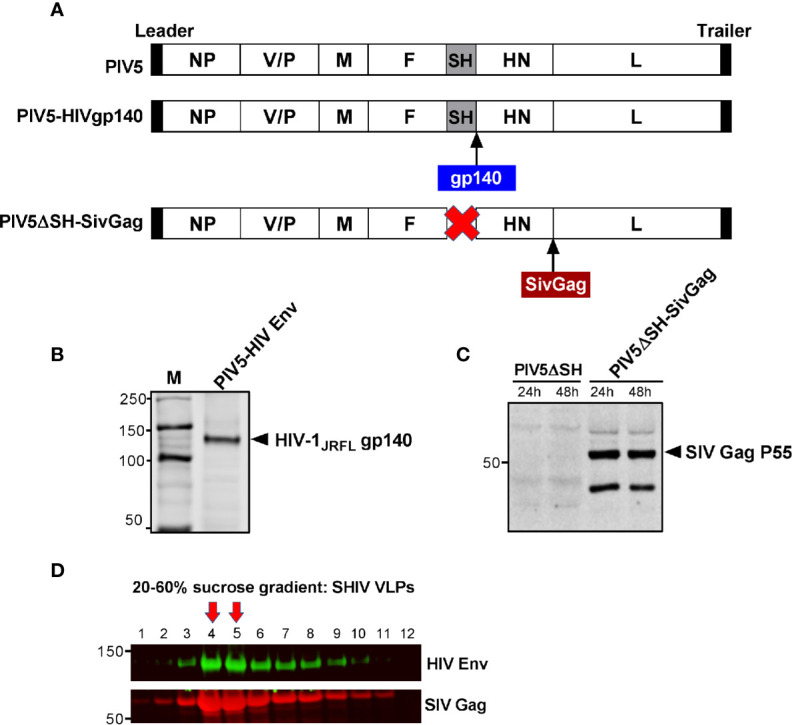
Generation and characterization of PIV5 and VLPs vaccines. (A) Schematics of PIV5- HIVgp140 and PIV5ΔSH-SivGag vaccine constructs. NP, nucleoprotein; V, V protein; P, phosphoprotein; M, matrix protein; F, fusion protein; SH, small hydrophobic protein; HN, hemagglutinin-neuraminidase protein; L, RNA-dependent RNA polymerase. Western blot analysis of PIV5 expressing (B) HIV-1 JRFL gp140, and (C) SIVmac239 Pr55Gag. (D) SHIV virus-like particles (VLPs) produced in 293F cells were analyzed by fractions collected from a 20% to 60% sucrose gradient using monoclonal antibody specific to HIV gp120 (top) or SIV Gag (bottom). Red arrows indicate the fractions with highest amount of Env and Gag in VLPs.